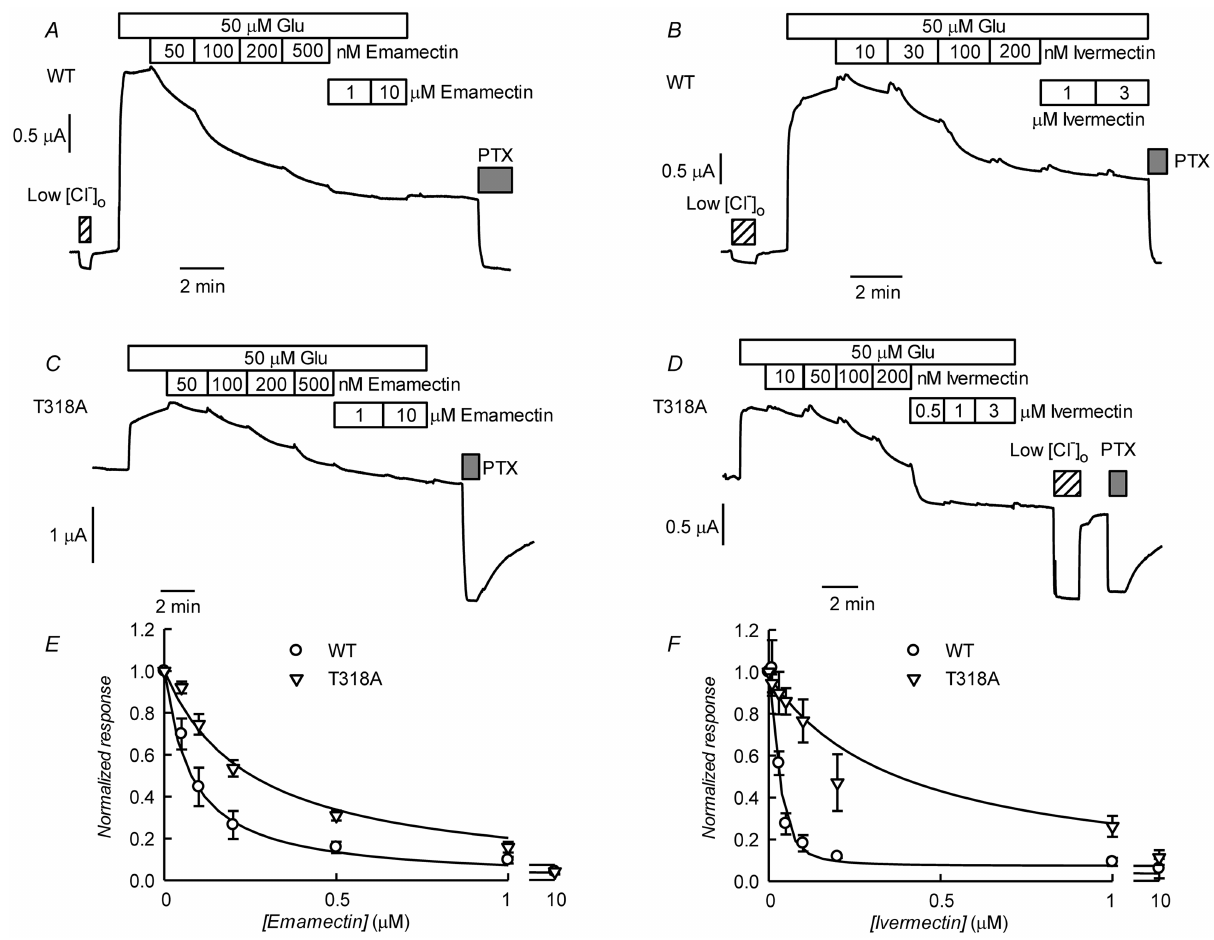
Figure 10. Effect of ivermectin or emamectin upon CrGluCl a -T318A-dependent currents. A and B. Effect of increasing concentrations of emamectin and ivermectin on WT CrGluCl a -dependent currents. The currents were first activated by addition of 50 m M glutamate and during continuous exposure to glutamate increasing concentrations of emamemctin or ivermectin were added. Reduction of [Cl 2 ] to 7.6 mM or addition of 100 mM PTX are also indicated. C and D. Similar experiments performed using the CrGluCl a -T318A mutant. E and F. Concentration dependence of the effects of avermectins on WT and T318A mutant CrGluCl a receptors. Normalised average responses to emamectin and ivermectin are shown (means 6 SEM, n=6 for all experiments shown). Fits of Hill decay functions to the average values are shown by the solid lines.